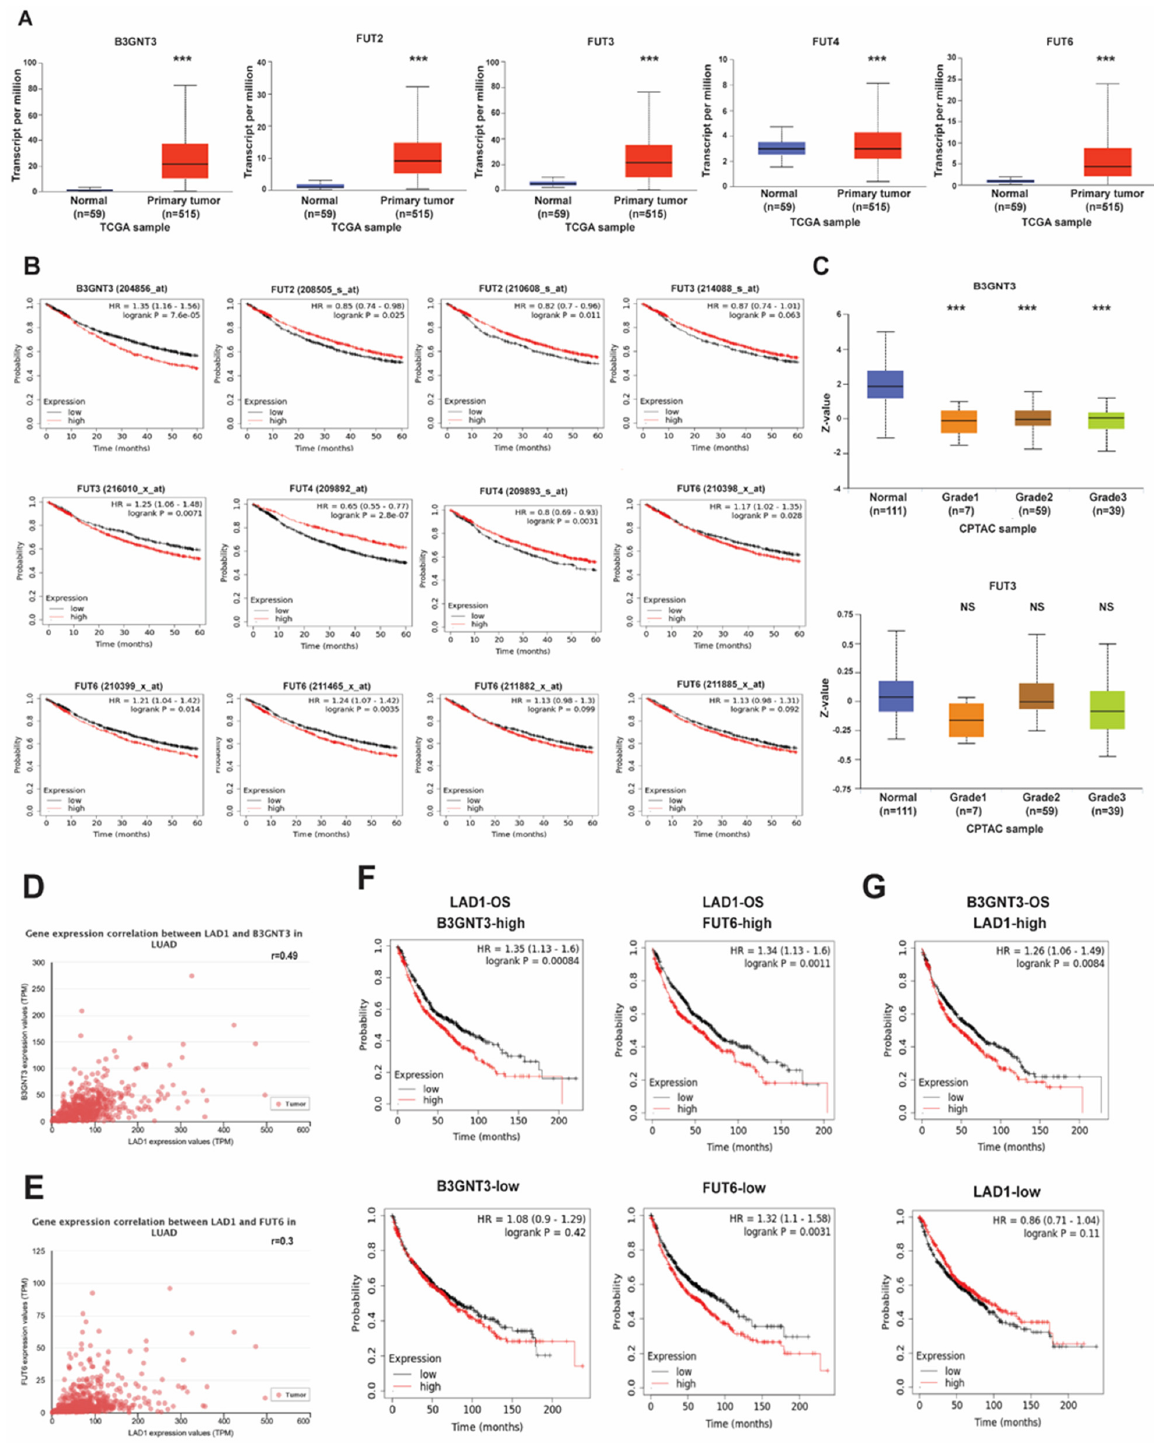
Figure 5. Correlation of metabolism associated genes with LAD1 expression in LUAD. ( A ) Metabolism − associated genes, including B3GNT3, FUT2, FUT3, FUT4, and FUT6, were expressed at higher levels in the primary tumor than in the normal parts in LUAD in the TCGA datasets. ( B ) Overall survival (OS) of these genes analyzed by the KM plotter. ( C ) The protein expressions of B3GNT3 and FUT3 among cancer grades in LUAD were shown in the CPTAC cohorts. ( D ) LAD1 expression is positively correlated with B3GNT3 and FUT6 ( E ) in the TCGA datasets. ( F ) Cross-analysis between either B3GNT3 or FUT6 and LAD1 in survival. ( G ) Poor overall survival links to high B3GNT3 expression levels only when LAD1 expressed high levels in LUAD. (ns, not significant; ***, p < 0.005).